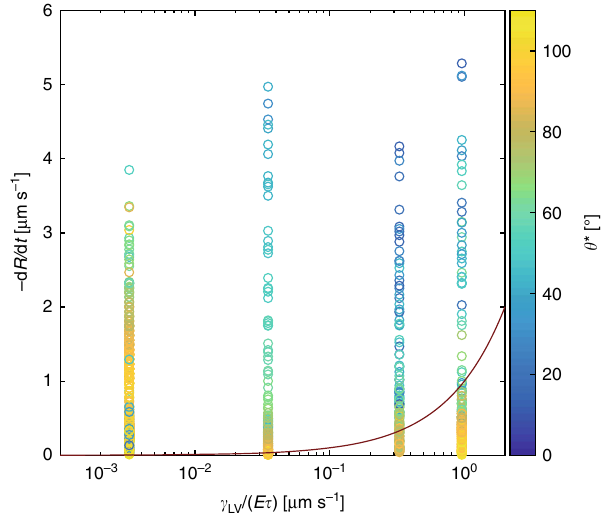
Fig. 4 Wetting transition phase diagram for droplet drying on soft materials. Contact line velocity, dR/dt , vs. the characteristic rate of substrate relaxation, γ LV /( E τ ), vs. the apparent contact angle, θ * .This plot contains droplet evaporation experiments on four materials, PDMS Sylgard 184 9:1 ( γ LV /( E τ ) = 3.3 × 10 − 3 µ m s − 1 ), PDMS Sylgard 184 30:1 ( γ LV /( E τ ) = 3.5 × 10 − 2 µ m s − 1 ), Silicone CY 52 – 276 5:6 ( γ LV /( E τ ) = 0.33 µ m s − 1 ), and Silicone CY 52 – 276 9:10 ( γ LV /( E τ ) = 0.98 µ m s − 1 ), and